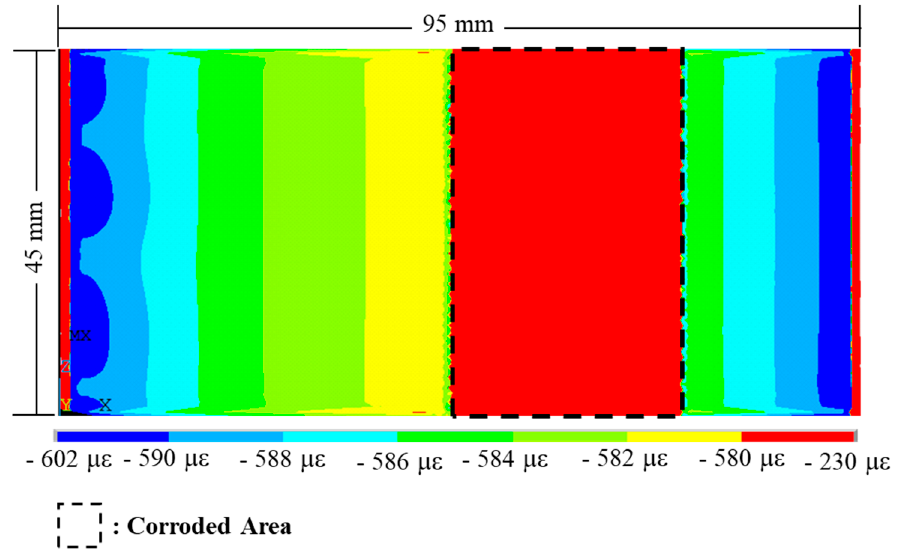
Figure 9. The side view of the xy plane of magnified strain distribution on the back side of the test piece in the axial direction, with a 0.27 mm reduction in thickness.